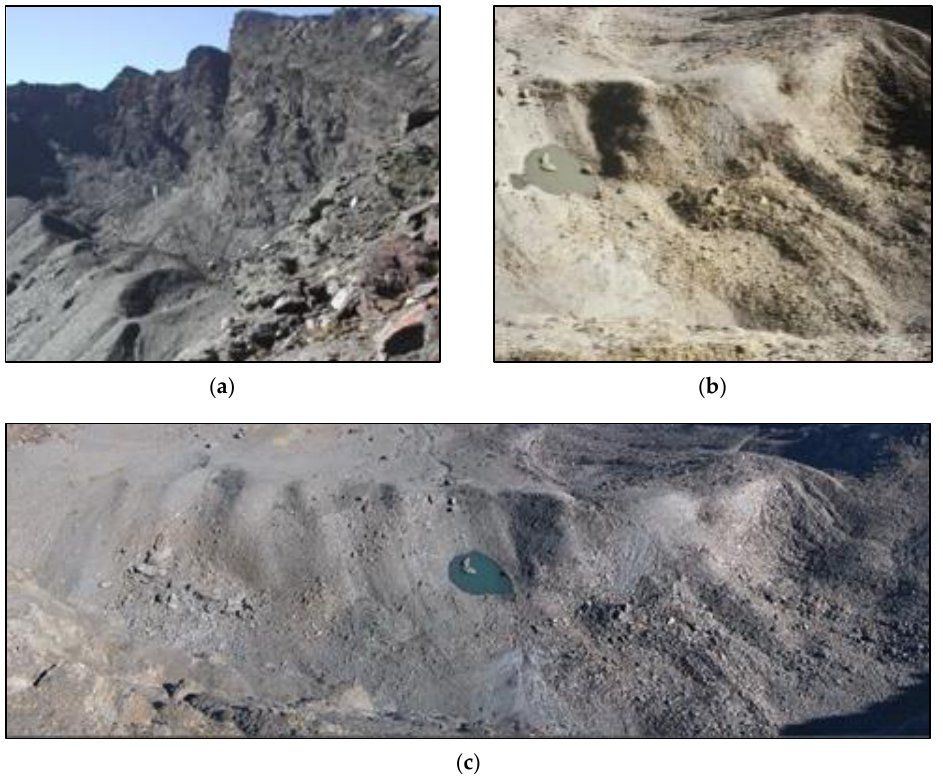
Figure 2. The Veleta and its rock glacier. ( a ) Panoramic view of the Veleta (viewed towards the east, photograph from August 2007). ( b ) Part of the Veleta rock glacier (eastern part of the base of the Veleta, 3100 m, photograph from August 2008). ( c ) Vertical panoramic view of the base of the Veleta (view from Picacho del Veleta at 3389 m, photograph from August 2006).